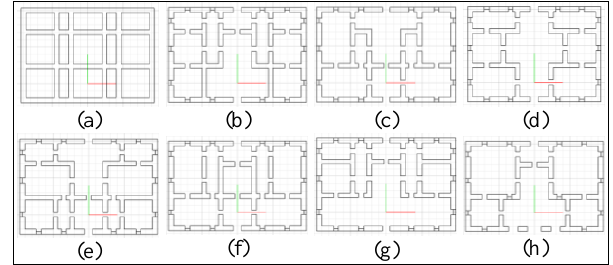
Figure 1. By applying grammar rules to a grid of rectangular spaces (a) various Palladian indoor designs can be generated (b to h).